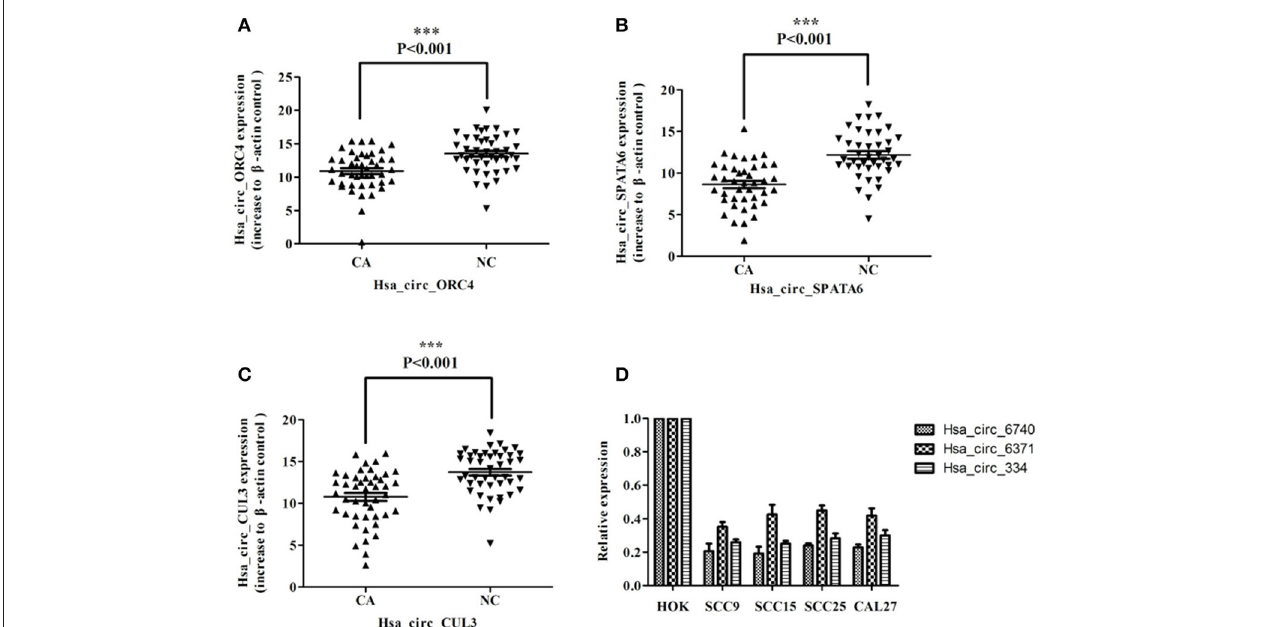
FIGURE 11 | Analysis of hsa_circ_ORC4, hsa_circ_SPATA6 and hsa_circ_CUL3 in OSCC tissues and cell lines. (A) The levels of hsa_circ_ORC4 in OSCC tissues are significantly higher than those in normal tissues. (B) The levels of hsa_circ_SPATA6 in OSCC tissues are significantly higher than those in normal tissues. (C) The levels of hsa_circ_CUL3 in OSCC tissues are significantly higher than those in normal tissues. (D) The expression of hsa_circ_ORC4, hsa_circ_ORC4 and hsa_circ_CUL3 in OSCC cell lines (SCC9, SCC15, SCC25, CAL27) compared with HOK (normal oral keratinocyte cell line).